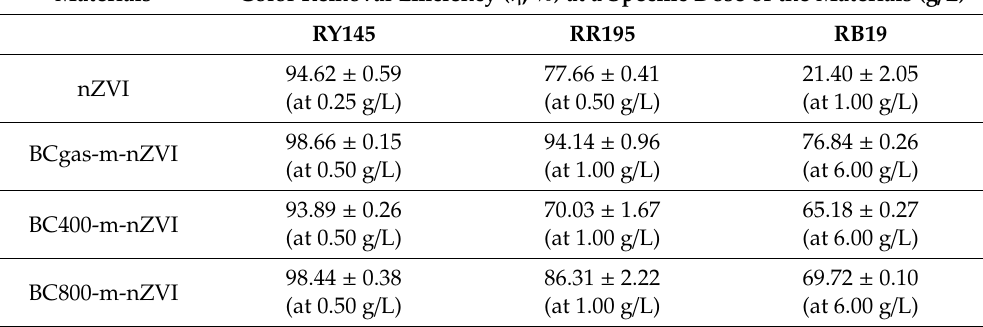
Table 3. Color removal e ffi ciency ( η ,%) of nano zero valent iron (nZVI), magnetic-nZVI gasified